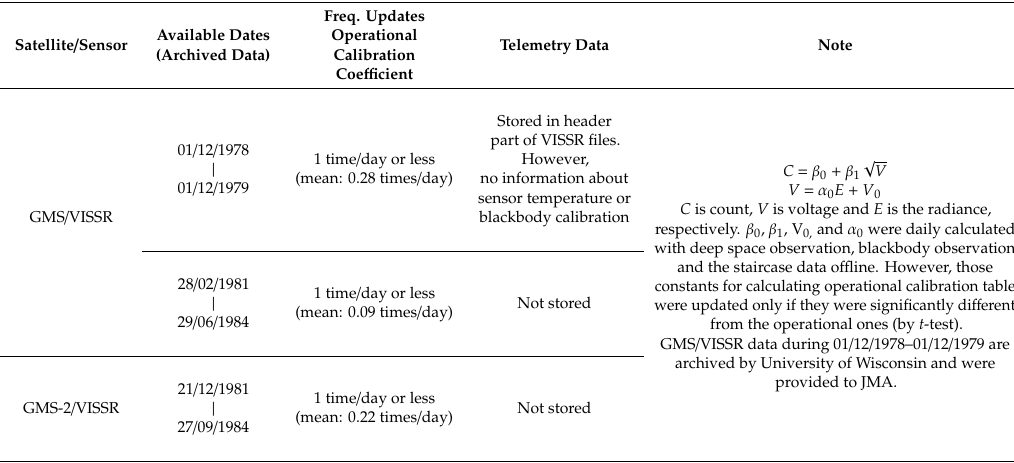
Table 2. Operational calibration updating for satellites from the GMS